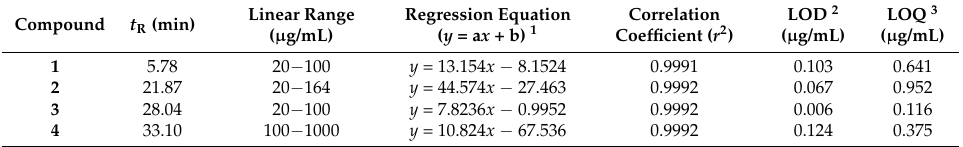
Table 1. Linear range, regression equation, correlation coefficients, LODs, and LOQs for compounds.